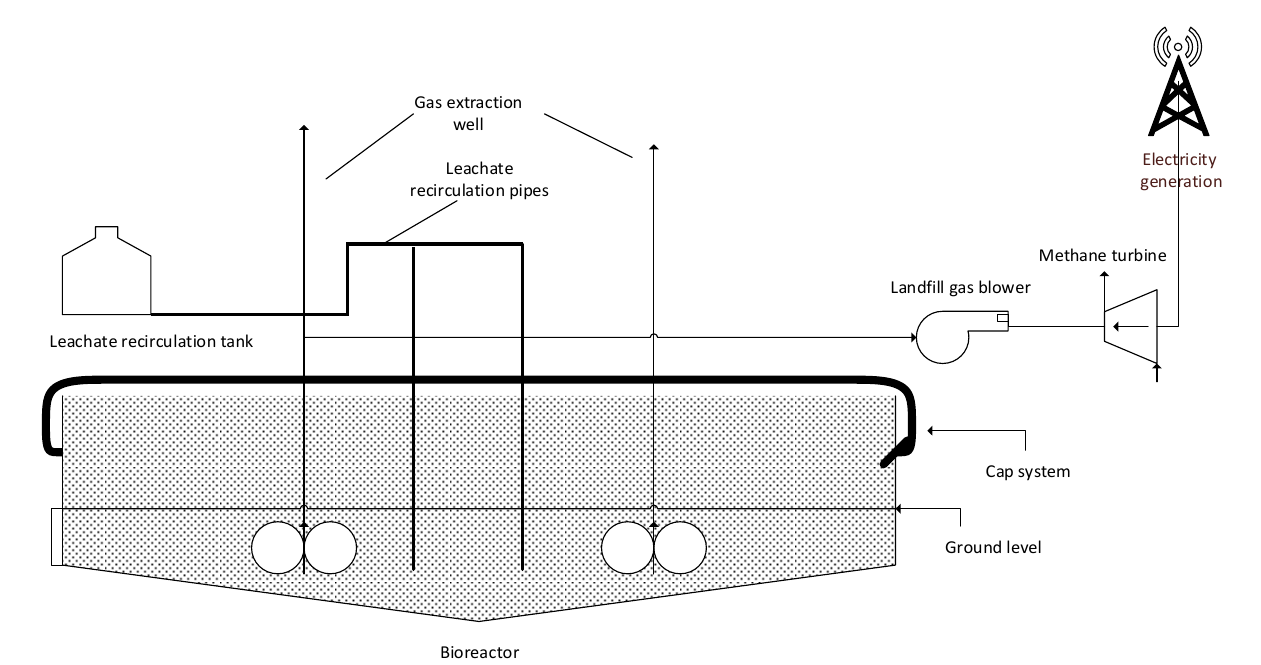
Figure 7. Process flow diagram of solid waste incineration plant.